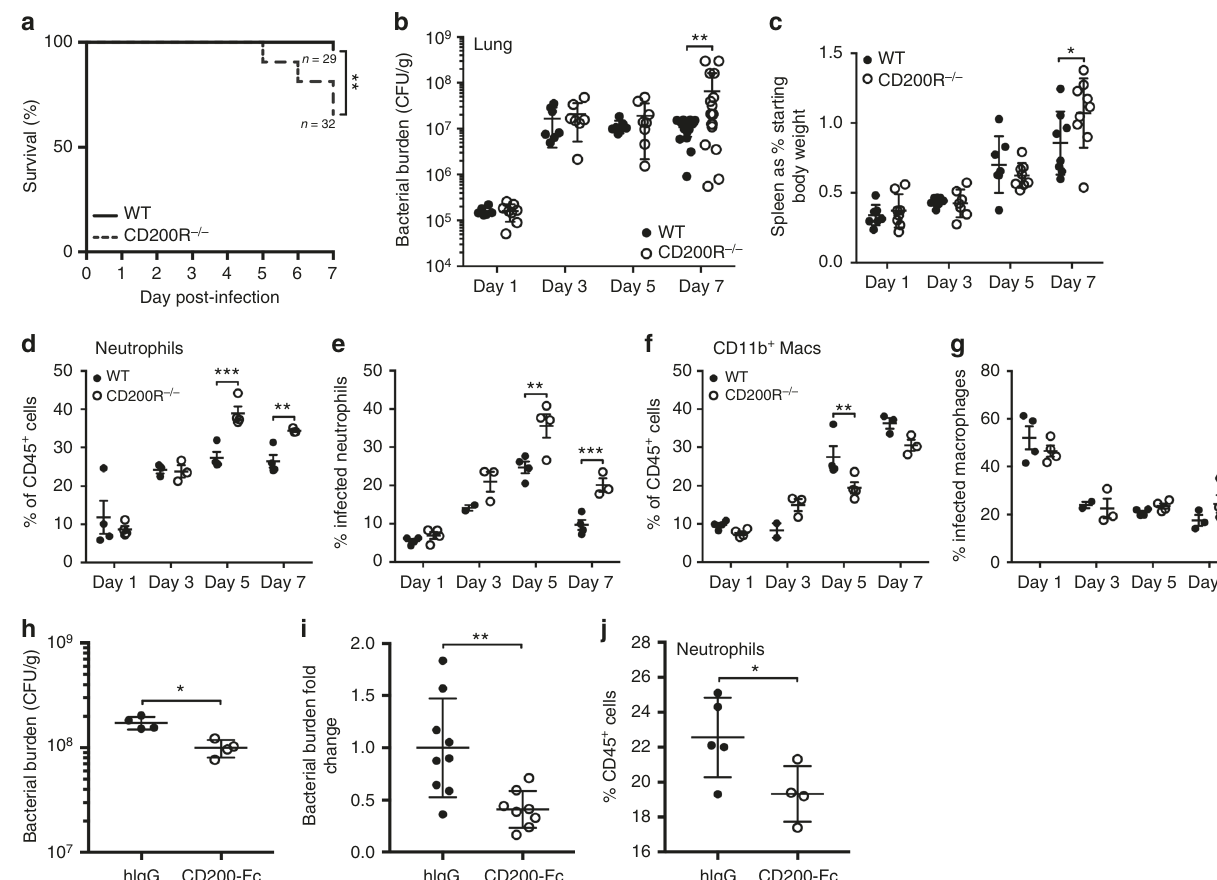
Fig. 2 Lack of CD200R in mice results in enhanced pulmonary F. tularensis burden associated with increased neutrophil in fl ux, displaying exacerbated infectious burden. WT and CD200R − / − C57BL/6 mice were infected IN with a challenge dose of 1000 CFU F. tularensis LVS. a Percentage survival of WT and CD200R − / − mice over 7 days of infection, with lack of survival considered if mice reached the humane endpoint (see methods). Data represent fi ve independent experiments (WT n = 29, CD200R − / − n = 32). b Bacterial burden (CFU/g) of the lung was enumerated at day 1, 3, 5 and 7 p.i. c Spleen size at day 1, 3, 5 and 7 p.i. presented as a percentage of body weight at day 0. d Quanti fi cation of neutrophils by fl ow cytometry as a percentage of total CD45 + cells at day 1, 3, 5 and 7 p.i. e Percentage of neutrophils infected with F. tularensis at day 1, 3, 5 and 7 p.i. determined by fl ow cytometry. f Quanti fi cation of CD11b + macrophages by fl ow cytometry as a percentage of total CD45 + cells at day 1, 3, 5 and 7 p.i. g Percentage of CD11b + macrophages infected with F. tularensis at day 1, 3, 5 and 7 p.i. determined by fl ow cytometry. h – j WT mice were infected IN with 1000 CFU F. tularensis and treated with 10 μ g